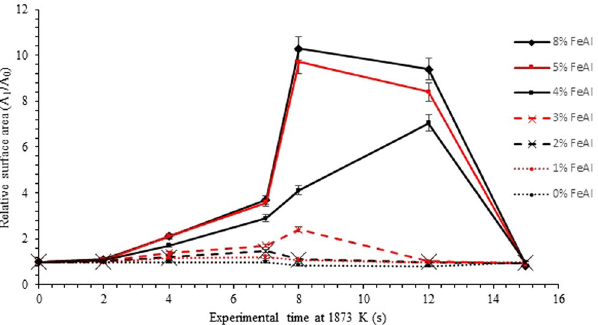
Figure 9. The surface area ratio profiles as deduced from image analyses of the HT-CSLM video (to the nearest 0.05). 1 in 15 frames have been analysed but only the points corresponding to those in Figs 3, 4, 5, 6 and 7 are